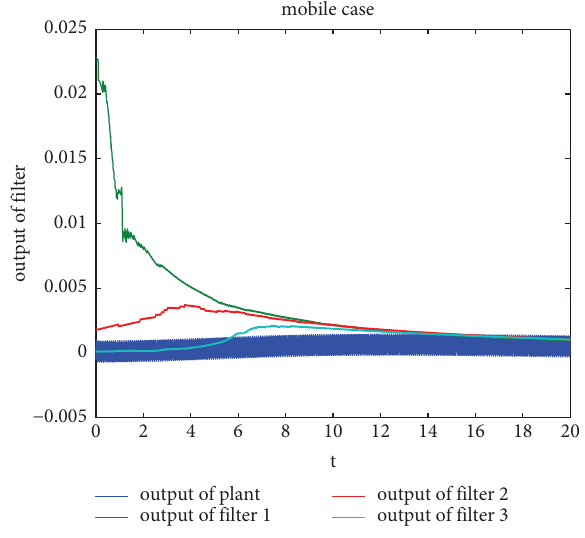
Figure 6: Output of plant and flters.